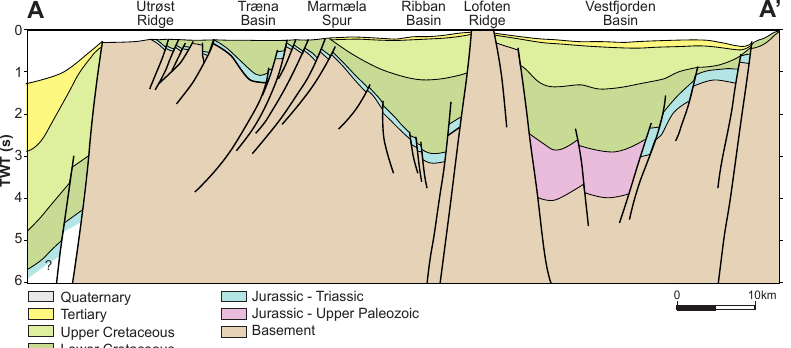
Figure 4. Geoseismic profile shows main structural elements of the Lofoten–Vesterålen margin. Location of profile in Fig. 3. Thin Jurassic sediments, which overlie Proterozoic basement, are a characteristic feature in the shelf area NW of the Lofoten–Vesterålen archipelago. The expanded, pre-Cretaceous sedimentary succession beneath the Vestfjorden Basin has been interpreted as part of a Late Permian–Early Triassic rift